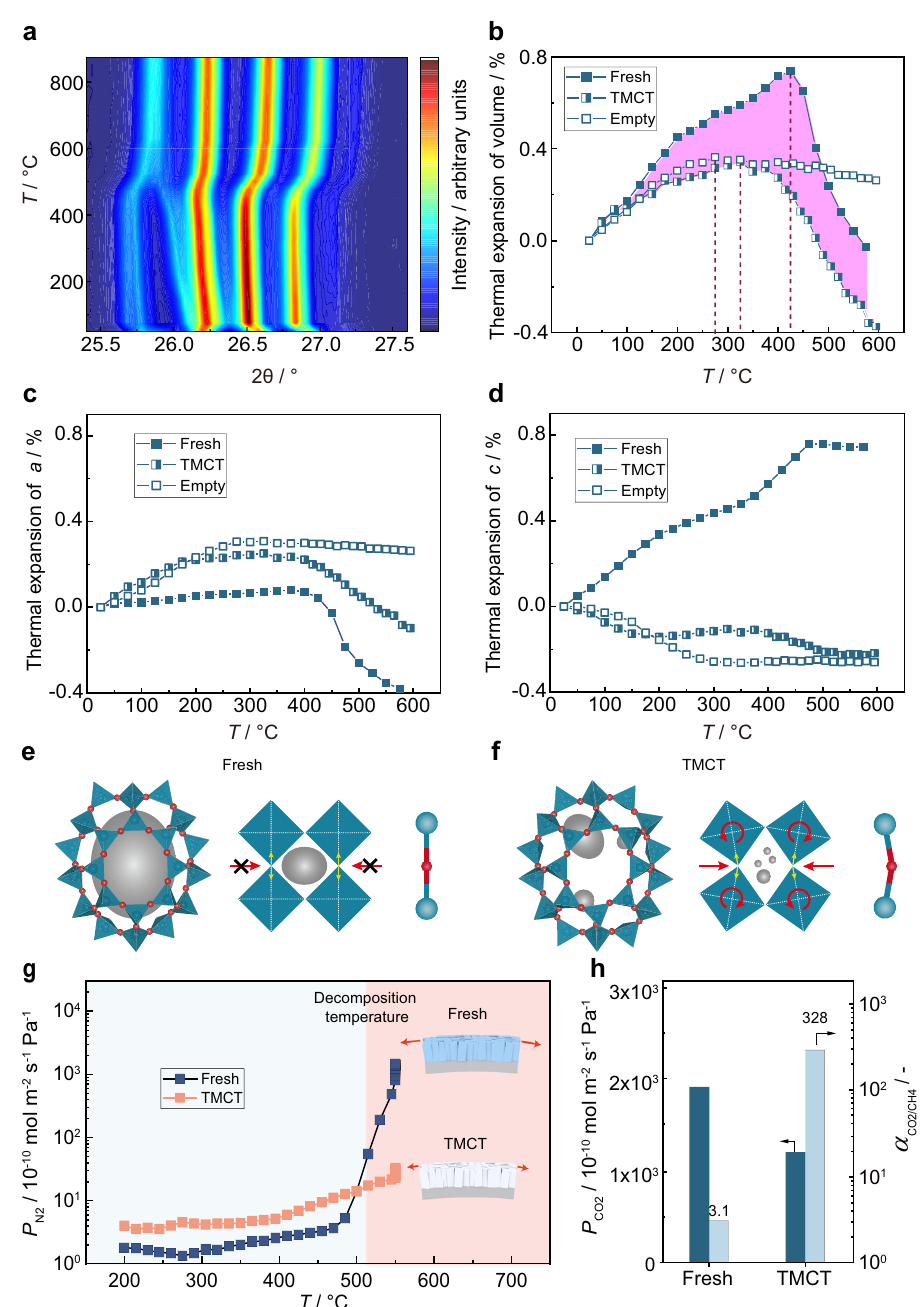
Fig. 4 In-situ characterization by high-temperature X-ray diffraction and gas permeation. a Isoline plot of the temperature evolution during in-situ template removal from fresh DD3R zeolite. b Thermal expansion of zeolite crystal volume. The pink area showed the difference in thermal expansion between fresh and TMCT samples. c , d Thermal expansion of zeolite lattice parameters. Fresh, as-synthesized zeolite; TMCT, overheating at 700 °C for 1 min; empty, 700 °C for 1 min followed by 550 °C calcination for 10 h. e , f Schematic diagram of rigid unit modes (RUMs) in zeolite structure. Red and blue nodes represent O and Si atoms, respectively. Gray blocks represent the guest molecule in the cage. g Pure N 2 permeance of fresh and TMCT membrane as function of calcination temperature with a heating rate of 0.5 °C min − 1 in air. h Binary CO 2 /CH 4 separation performance of the membranes from ( g ). Test condition: room temperature and 2 bar feed pressure. Source data are provided as a Source Data fi